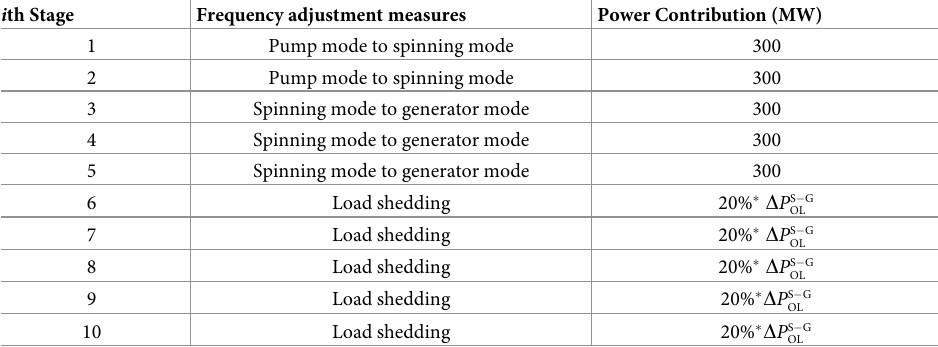
Table 7. Stage-by-stage joint control scheme.